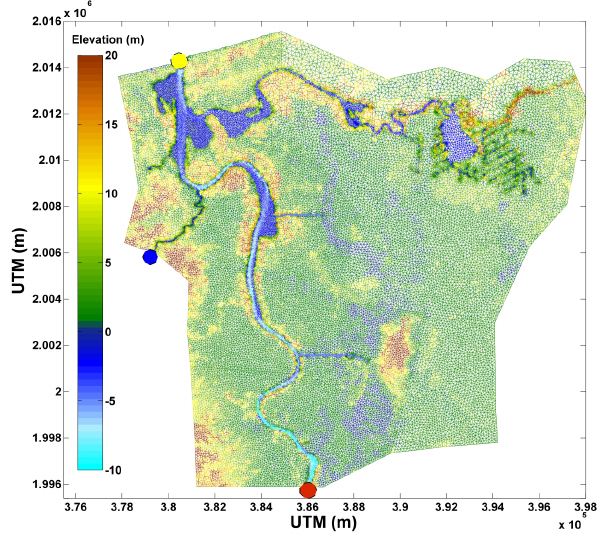
Figure 7. Model domain along with the numerical mesh and eleva- tion data in the study area. Boundary conditions are represented by the blue dot: Agua Dulcita river; red dot: input hydrograph; yellow dot: river